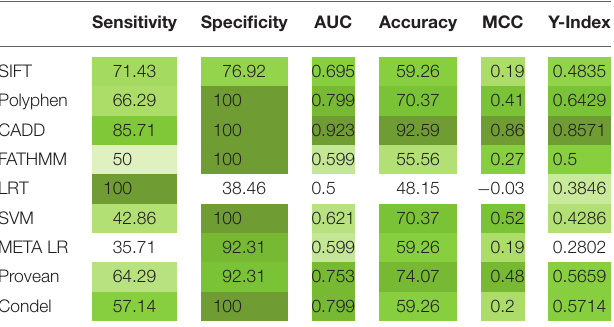
TABLE 2 | Specificity, sensitivity analysis report of IL10 RA mutation predictions by different computational methods. Sensitivity